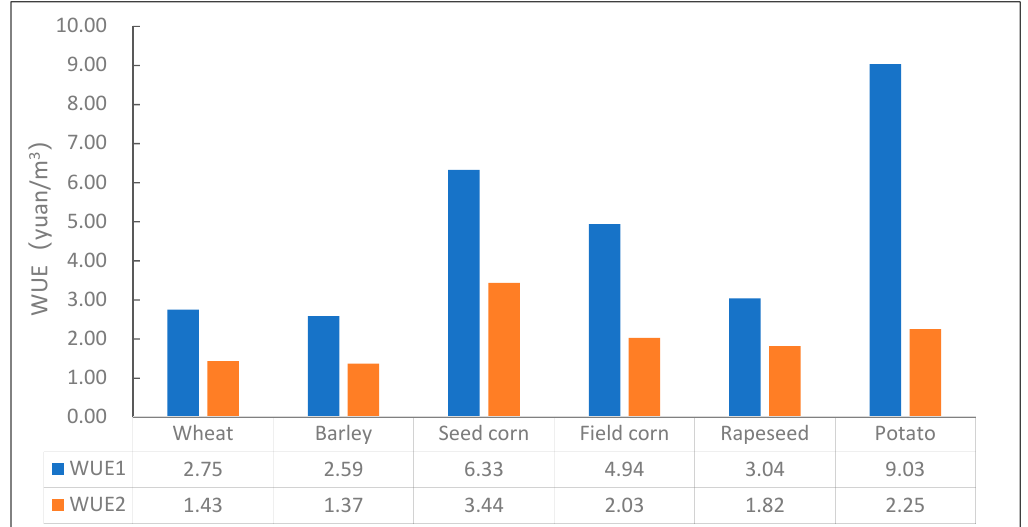
Figure 4. WUE of the crops in the study area.